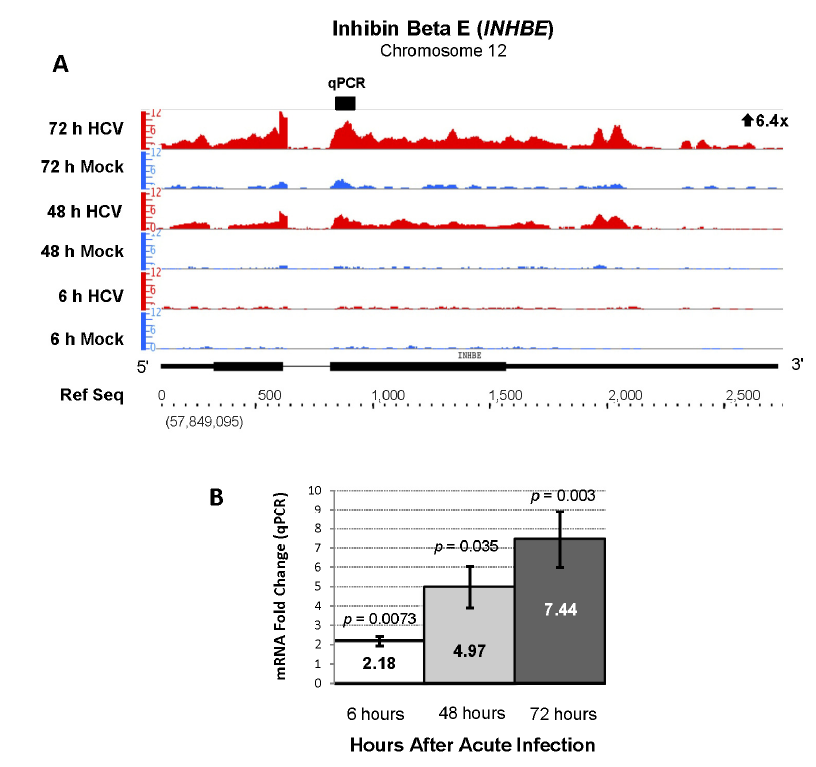
Figure 6. Increased expression of inhibin beta E ( INHBE , Chr 12, + strand) during acute HCV infection. The RNA sequencing (6.4 fold increase, FDR = 1324.3) ( A ) and qPCR results ( B ) are presented as in Figure